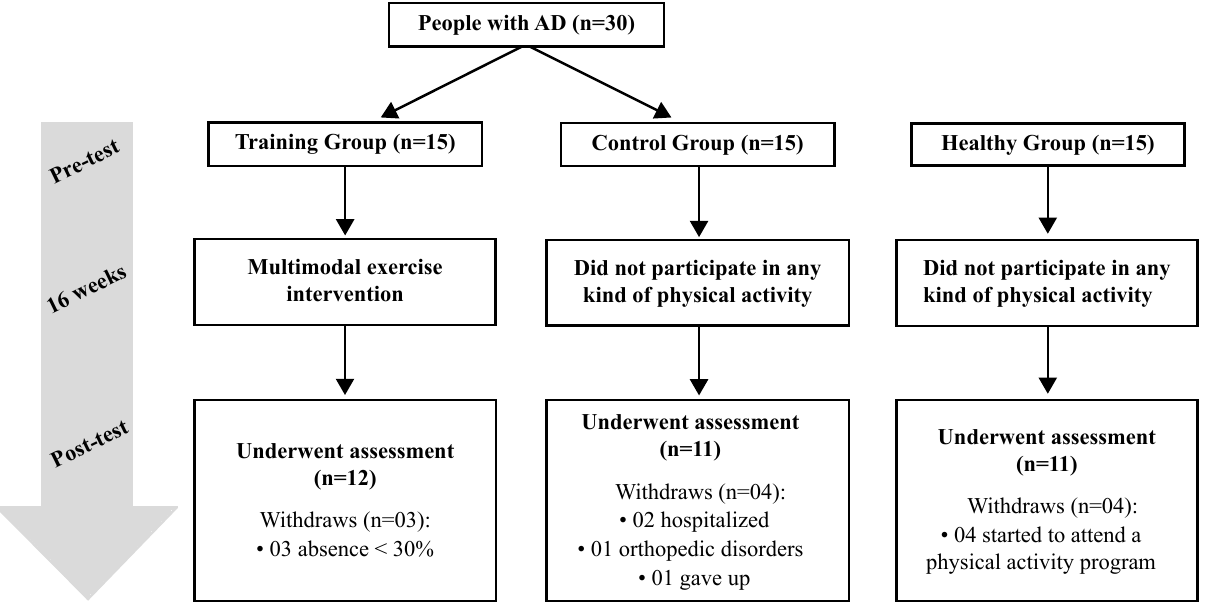
Figure 1. Flowchart of training and assessment of study